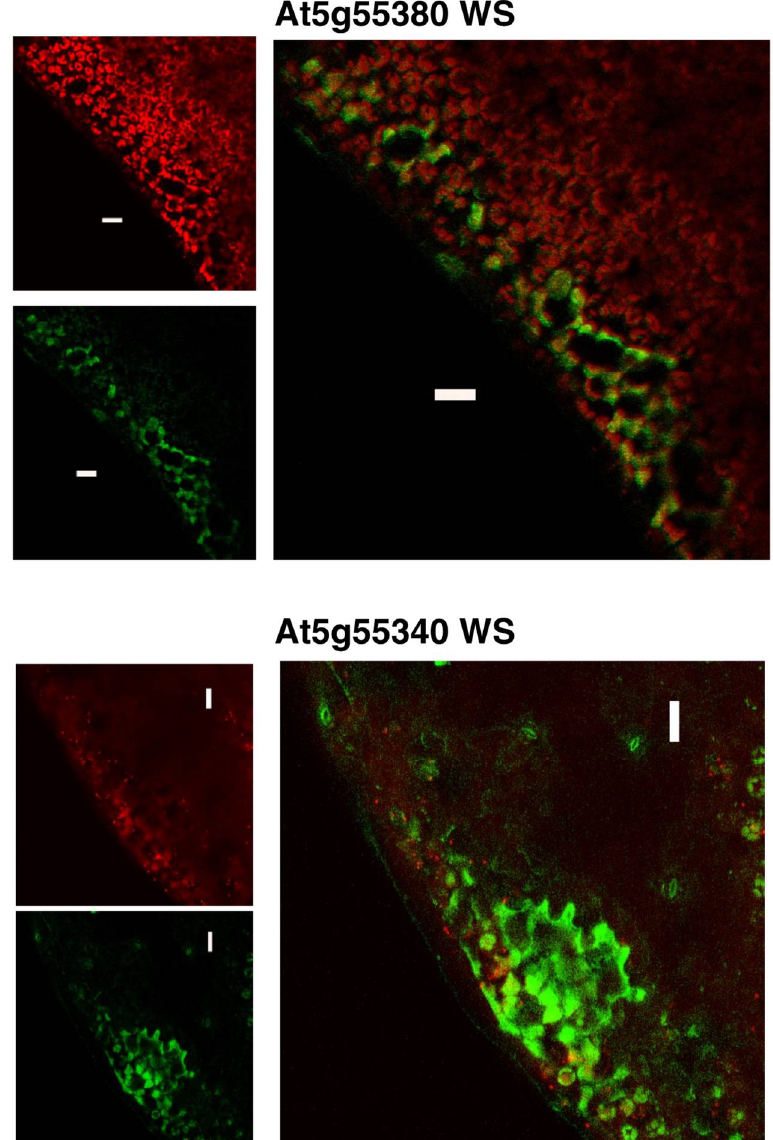
Figure 6. Subcellular localization of WS proteins. GFP fluorescence generated by the transgenic expression of WS-GFP fusions is compared to the auto-fluorescence that visualizes the location of chloroplasts. Images are of the epidermis and subepidermal cell layer of leaf tissue from 15 DAI transgenic plants expressing GFP-fusions of the indicated WS genes.